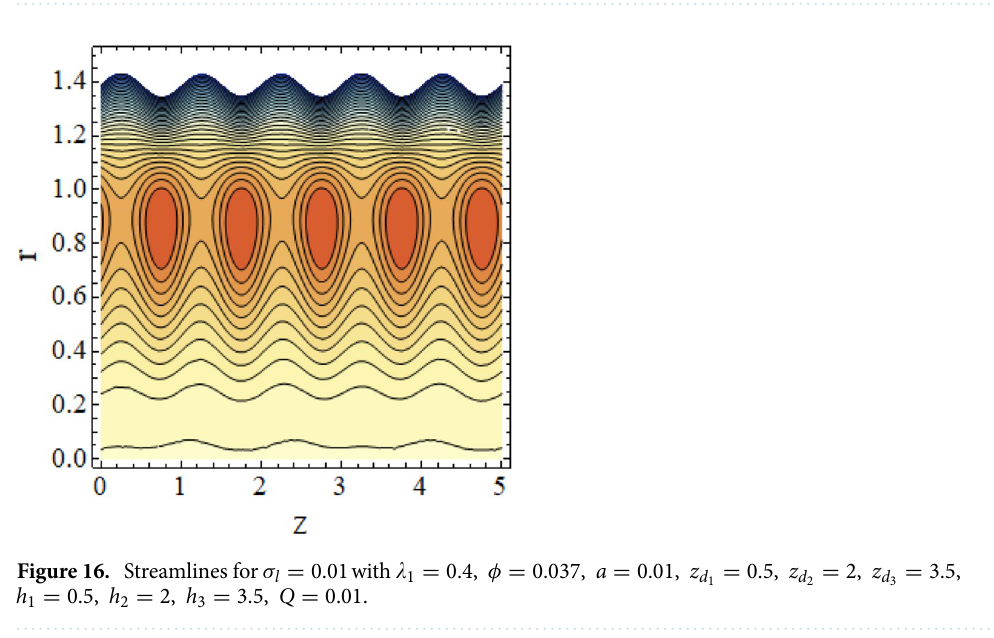
Figure 15. Streamlines for Q = 0.75 with (cid:31) 1 = 0.4, φ = 0.037, a = 0.01, z d 1 = 0.5, z d 2 = 2, z d 3 = 3.5, h 1 = 0.5, h 2 = 2, h 3 = 3.5.